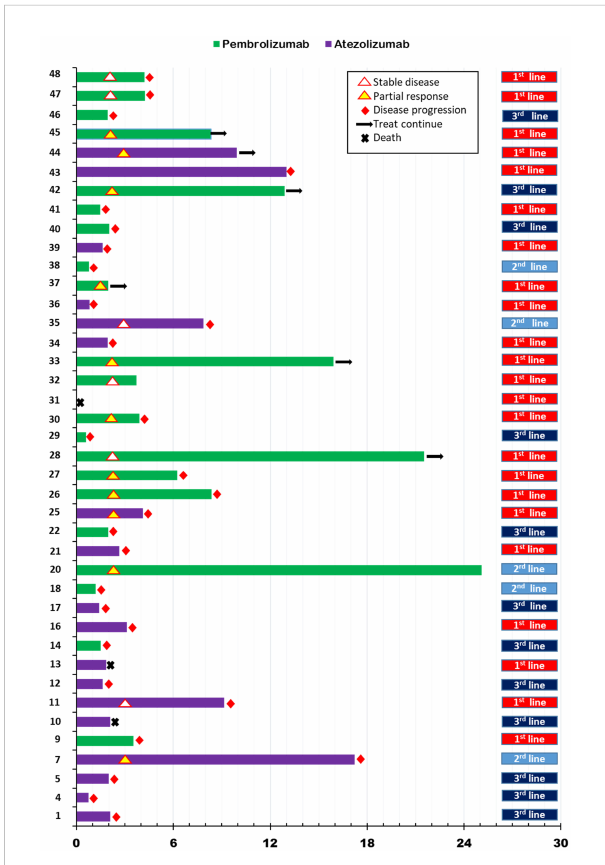
FIGURE 1 Swimmer ’ s plot for progression free survival according to immune checkpoint inhibitor treatment in metastatic